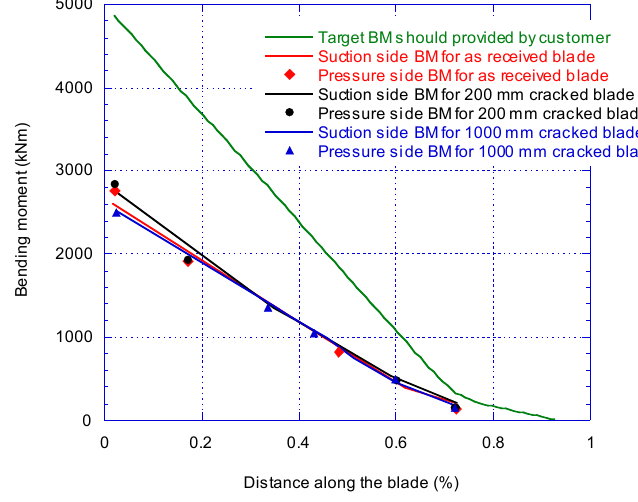
Figure 10. Comparison of target and measured BM distribution with crack.